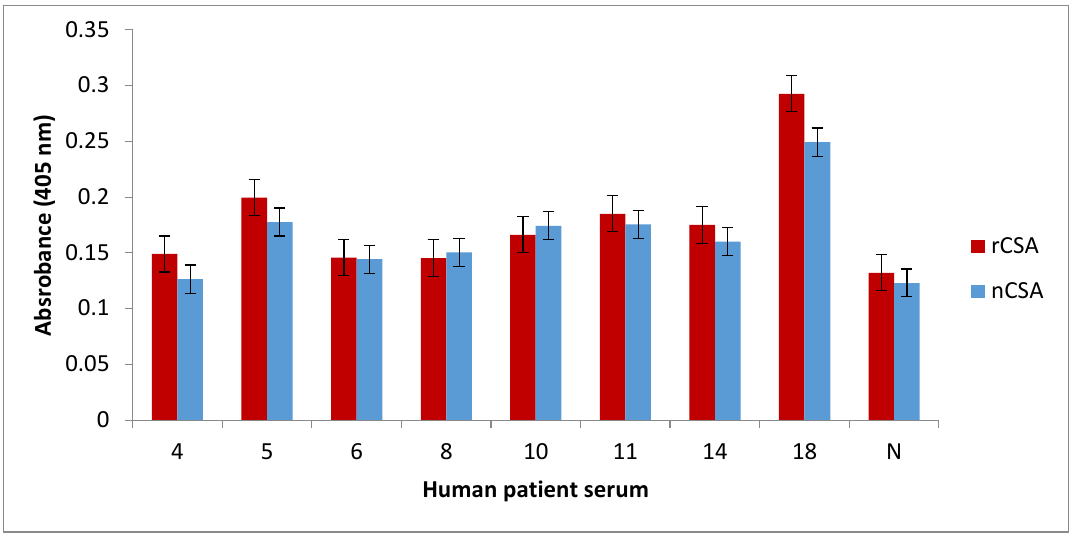
Figure 4. Comparison of the binding activity of human sIgE against recombinant CSA and natural CSA. N denotes serum from healthy subjects and numbers denote different patients’ sera sensitised to nCSA. Data are average of triplicate mean +/− SEM. sIgE: specific immunoglobulin E; SEM: standard error of mean.